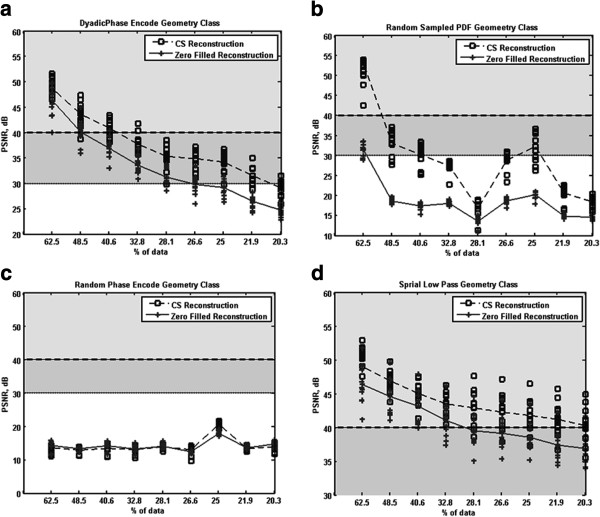
Reconstruction image quality assessment. The top row contains reconstructions from various SLP sampling geometries, not necessarily using the optimal reconstruction parameters. The bottom row contains reconstruction from the RSP sampling geometry class. (a) and (e) are the original ON images. (b) and (f) are marginal reconstructions of 28.35 and 24.22 dB, respectively. (c) and (g) are acceptable reconstruction of 34.97 and 39.64 dB. (d) and (h) are excellent reconstructions of 48.35 and 56.69 dB, respectively.